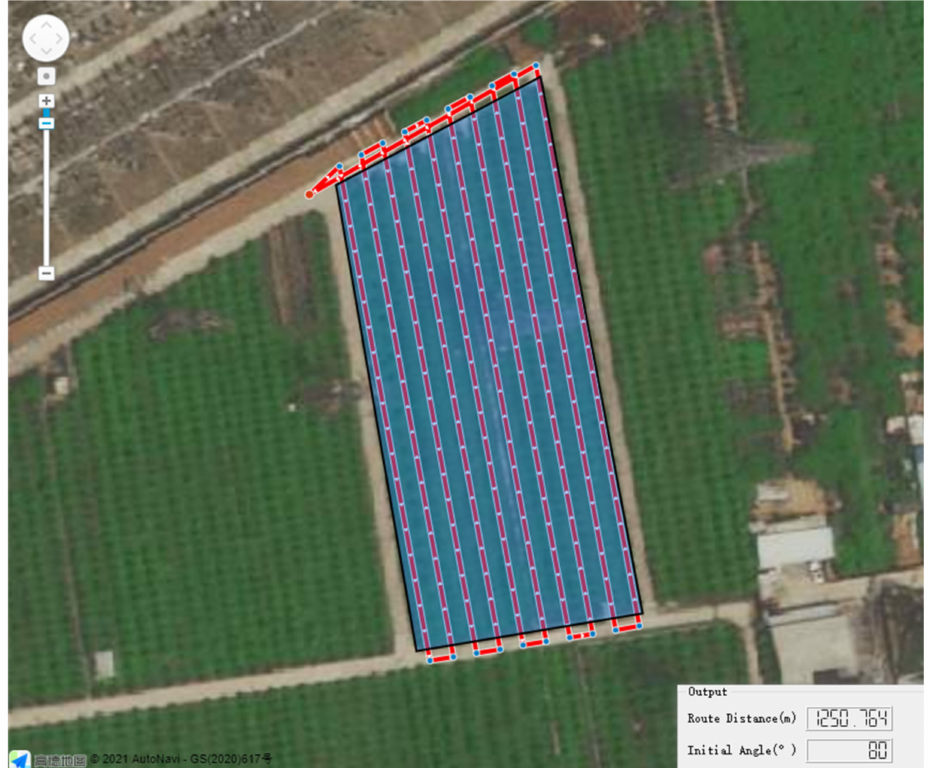
Figure 8. Results of the route-planning simulation software. The red lines with arrows are the calculated optimal route, the blue points are the waypoints, and red point is the takeoff and landing point.